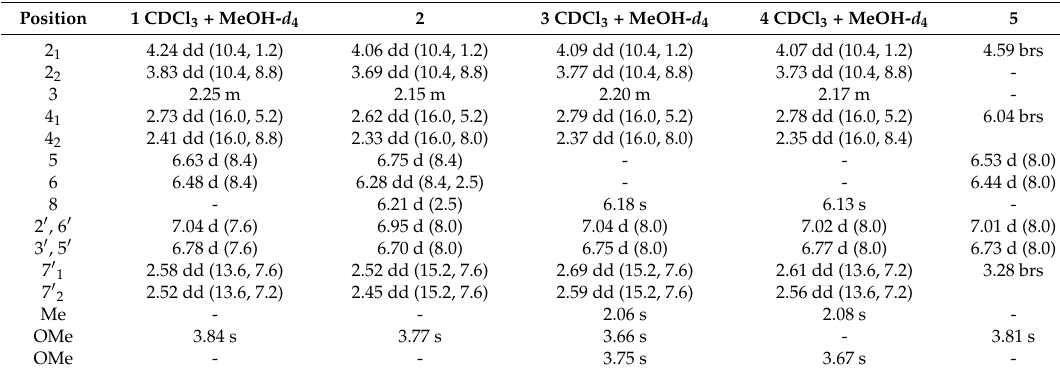
Table 1. 1 H-NMR-Spectral Data of Compounds 1 – 5 (400 MHz, CDCl 3 , or CDCl 3 + MeOH- d 4 , δ -values in ppm, J values in Hz).